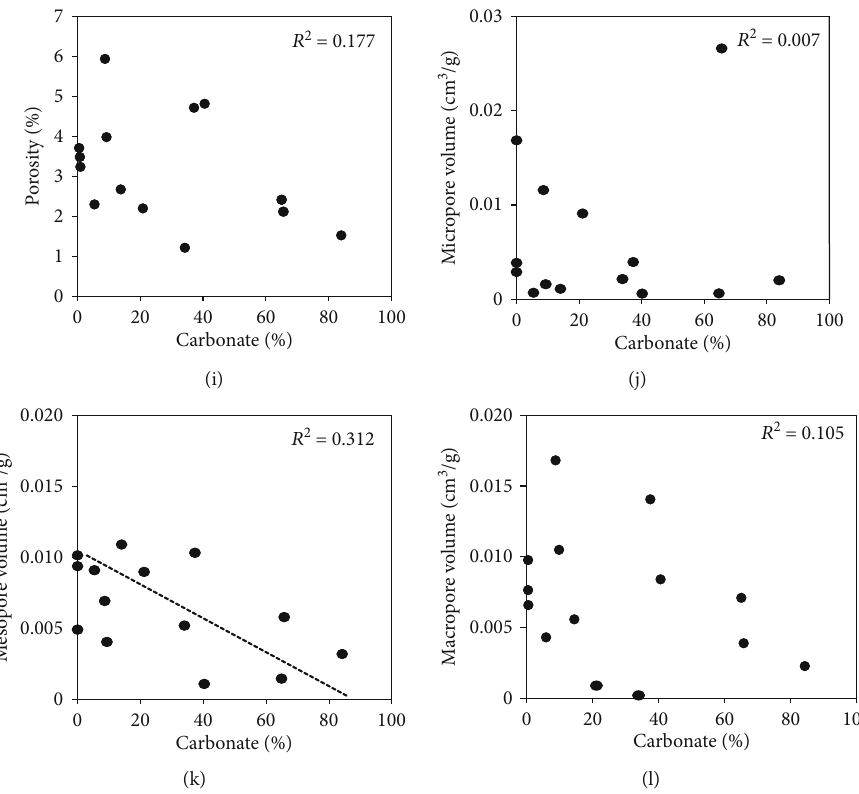
Figure 9: Correlation between minerals (quartz, clay, and carbonate) and porosity, volumes of micropores, mesopores, and macropores for